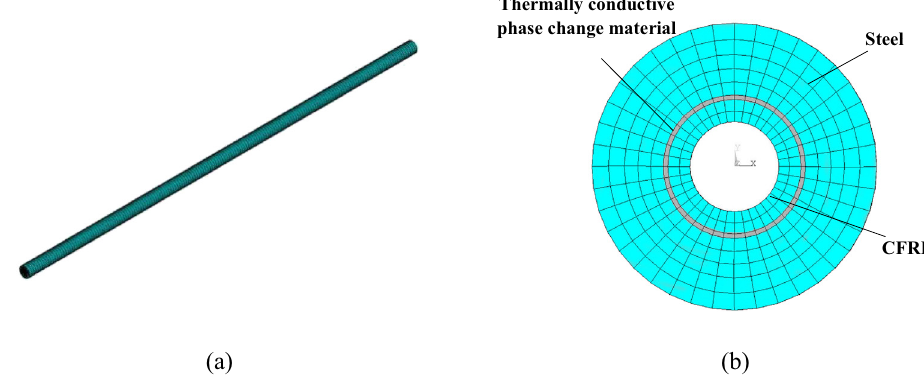
Figure 4: FE model of ball screw based on inner - embedded CFRP: ( a ) isometric view and ( b ) orthographic